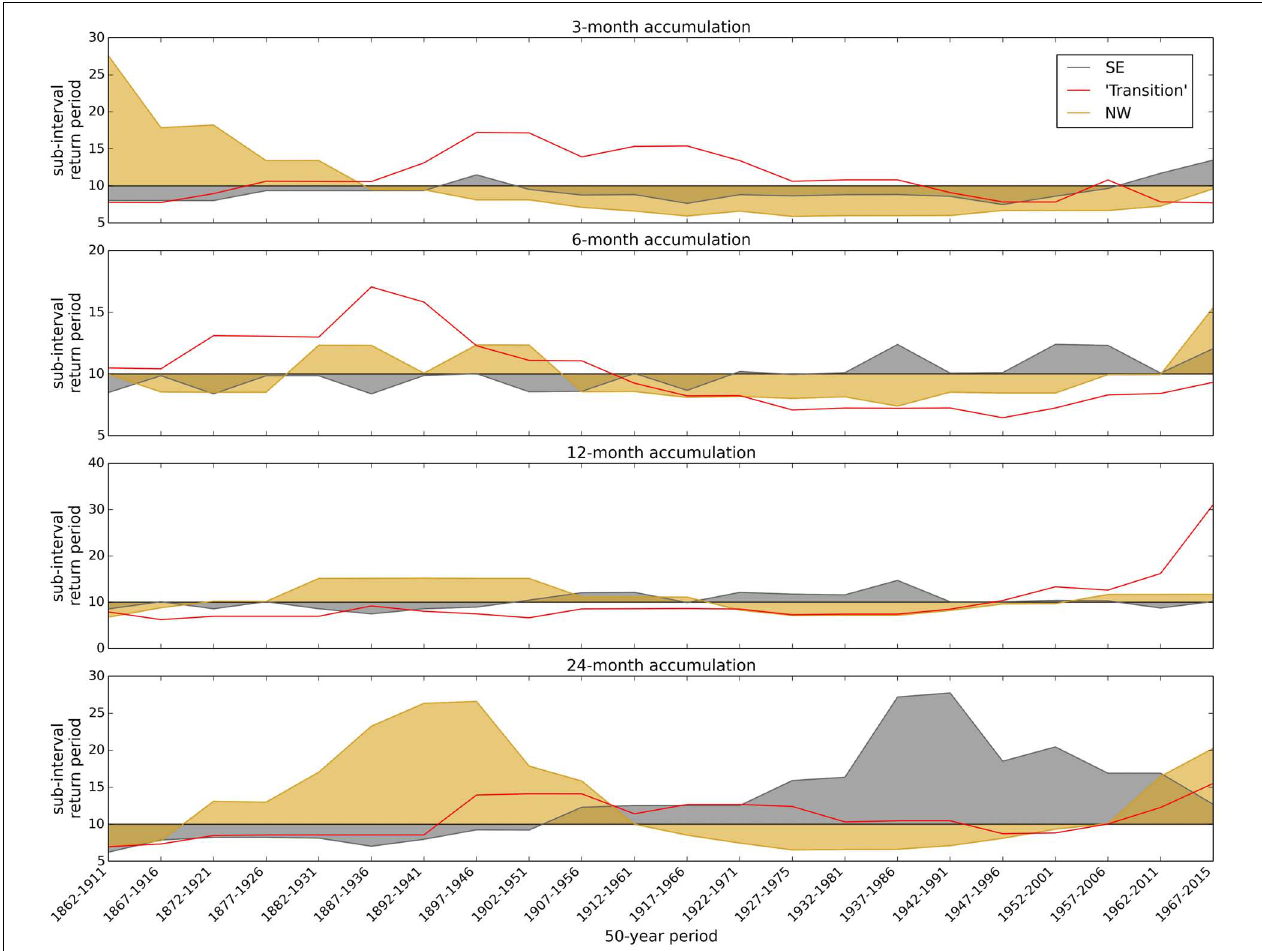
FIGURE 7 | Temporal evolution of the “sub-interval return period” for a “global 10-year return level” as defined in Section “Data and Methods - Trend Analysis” for different 50-year time windows.